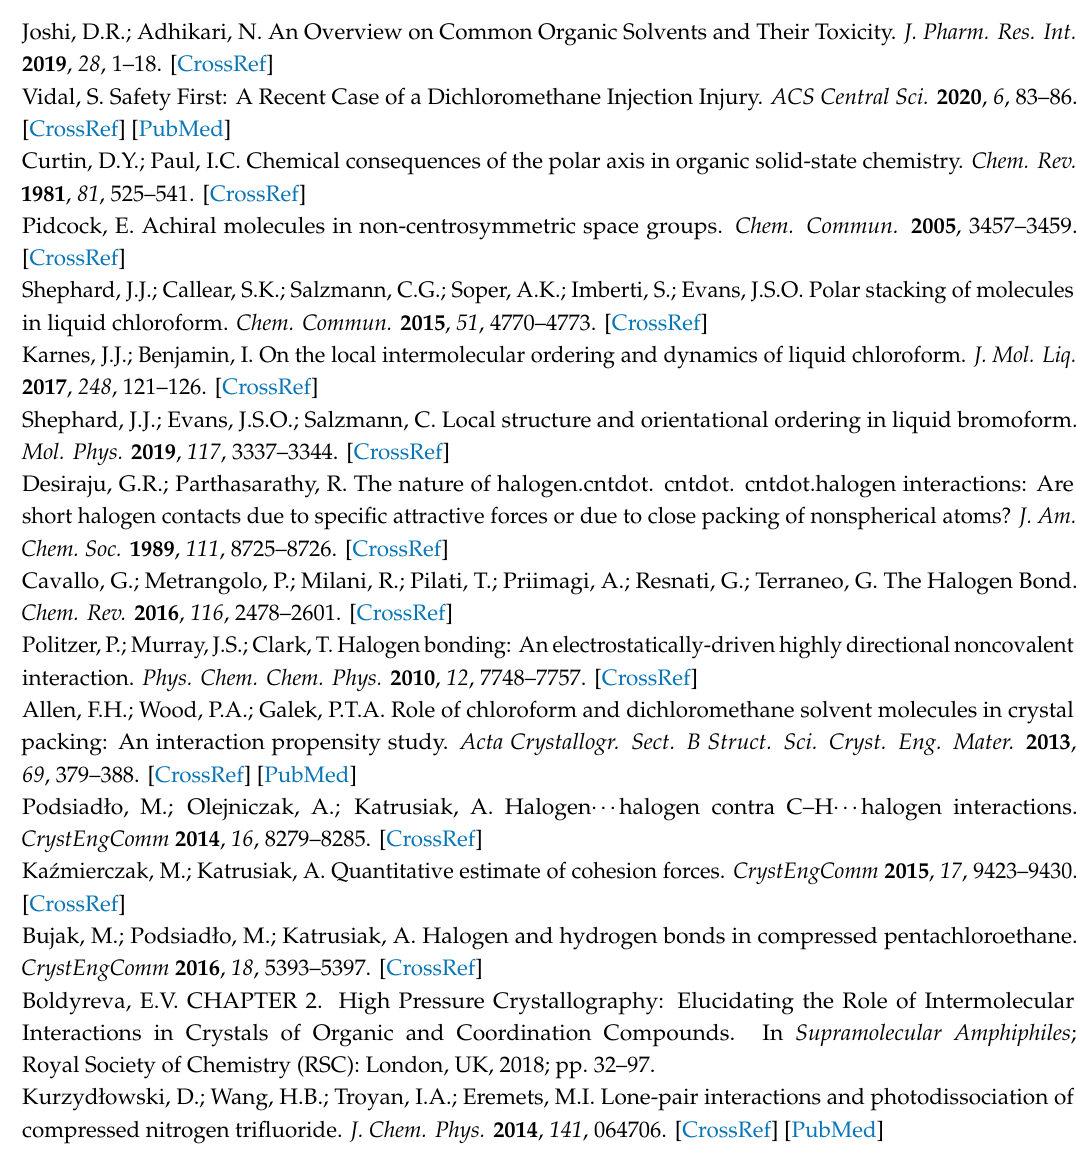
Table S1: Comparison of the calculated and experimental geometry of CHCl 3 structures, Table S2: Comparison of the calculated and experimental vibrations of Raman-active modes of CHCl 3 , Table S3: Comparison of the calculated and experimental geometry of CH 2 Cl 2 structures, Table S4: Comparison of the calculated and experimental vibrations of the Raman-active modes of CH 2 Cl 2 , Figure S1: Calculated phonon dispersion curves for the Pnma structure of CHCl 3 , and the Pbcn structure of CH 2 Cl 2 at 32